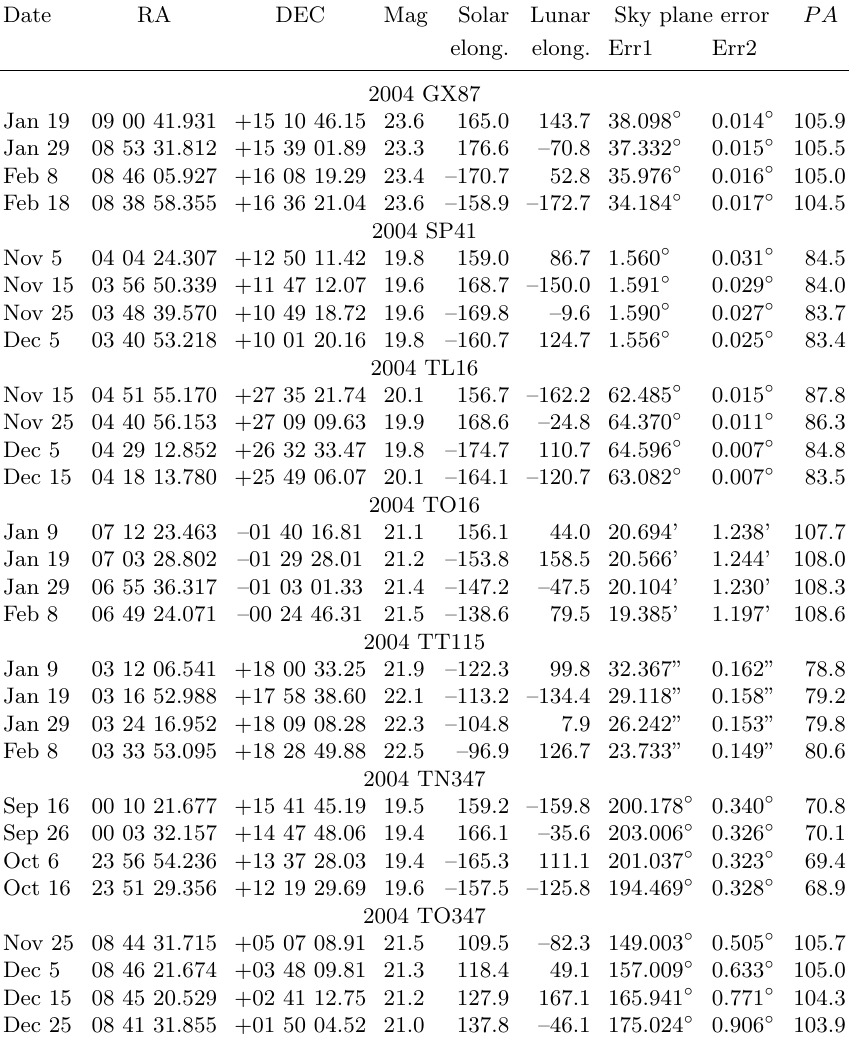
Table 4. Ephemerides for 2015 of the asteroids with orbits of low accuracy discovered at the Mol_etai Observatory (for the geocentric observer).